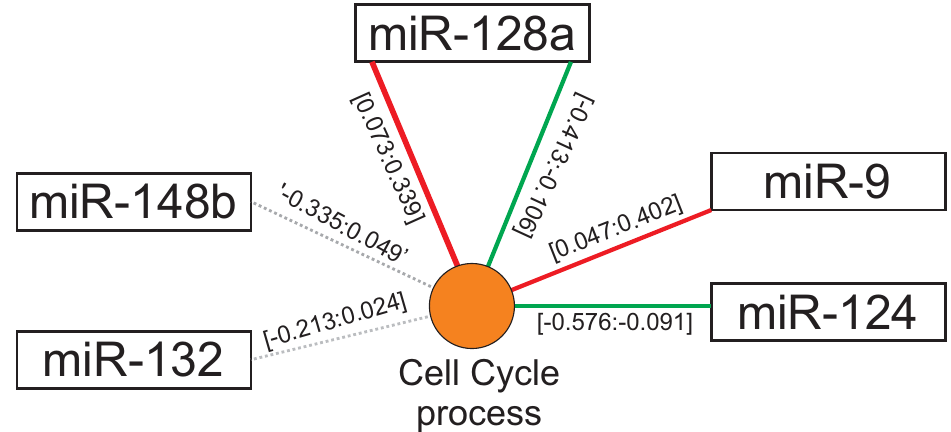
Figure 3. Combined action of distinct regulatory clusters. Each line represents a regulatory cluster connecting miRNAs to the enriched biological term associated with the cluster. The numbers within brackets represent the minimum and maximum fold change values of that cluster. Red lines represent up-regulated gene clusters, green lines represent down-regulated gene clusters, and gray dashed lines represent clusters of genes apparently not regulated by the